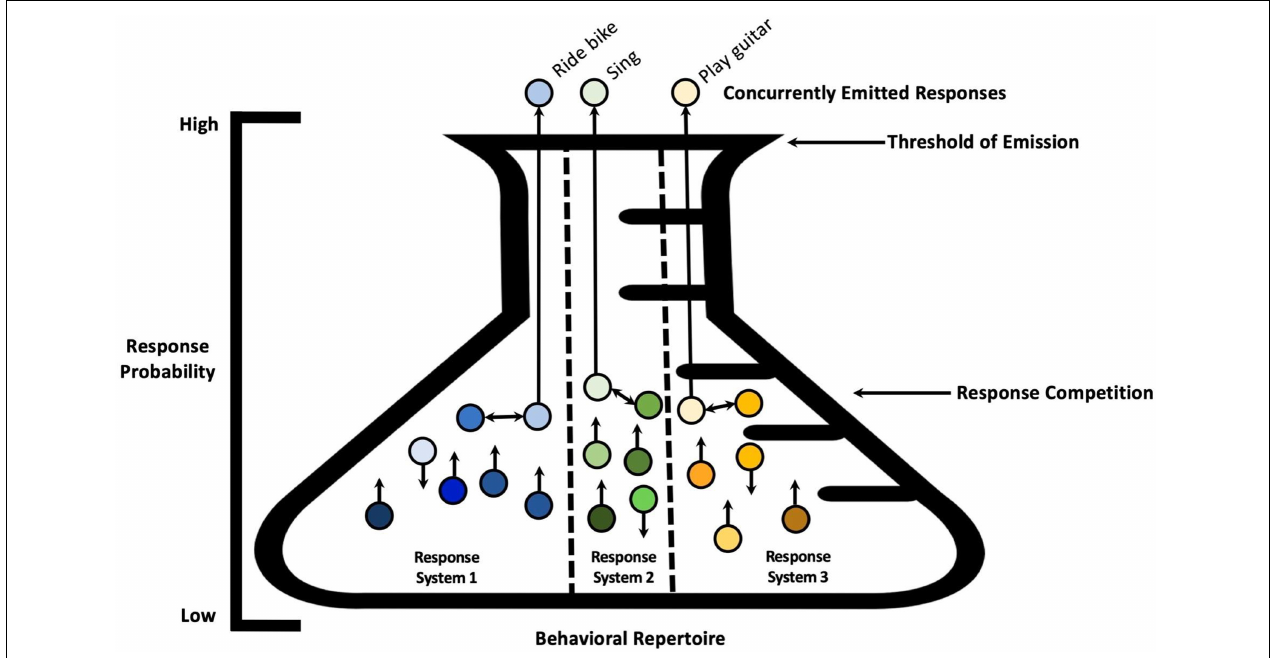
FIGURE 2 | Emission of three responses at a given time belonging to three separate response systems. A visual metaphor showing three response systems within the behavioral repertoire, and the simultaneous emission of three behavioral responses belonging to three separate response systems. Antagonistic responses within each response system are noted with bidirectional arrows between the responses. Since these responses belong to separate response systems, the individual can learn to emit them at the same time, as there are no anatomical limitations preventing